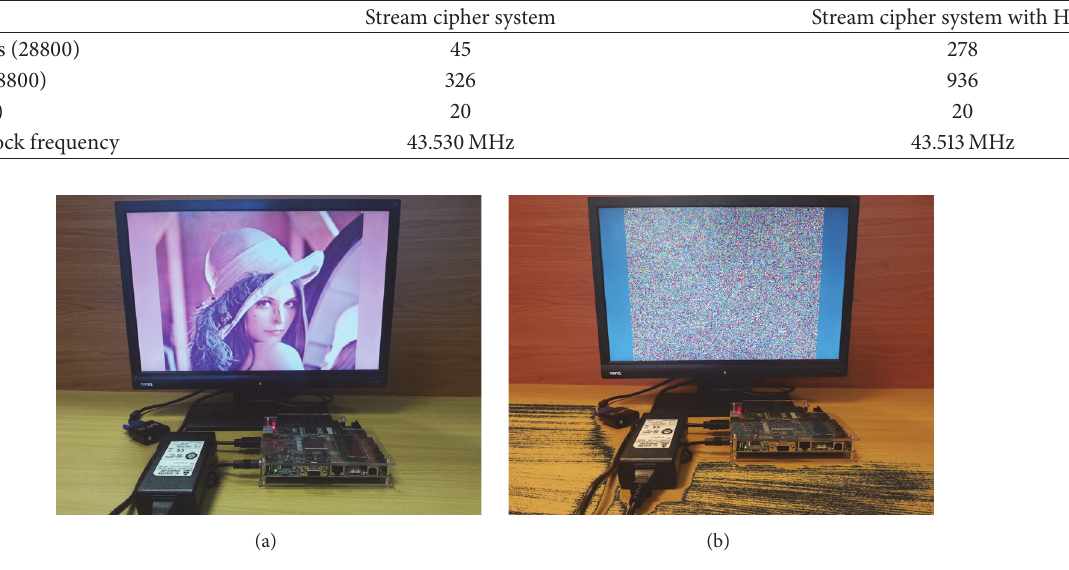
Figure 21: Standalone image encryption system. (a) Decrypted image. (b) Encrypted image.